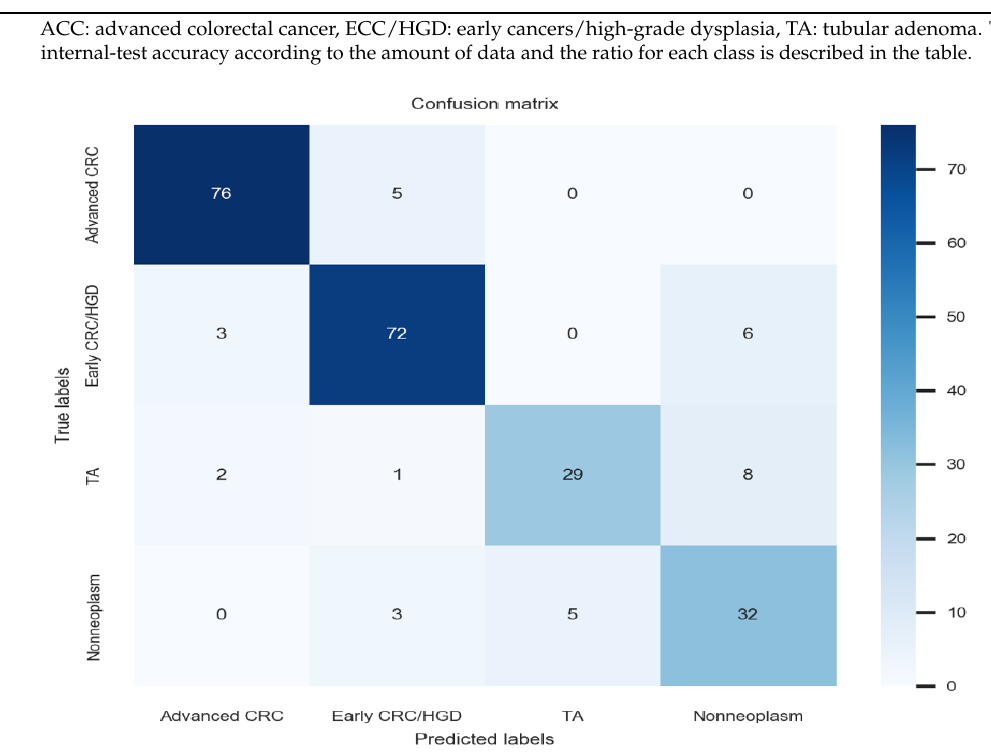
Figure 2. Best-performing artificial intelligence model confusion matrix (internal-test). ACC: ad- vanced colorectal cancer, ECC/HGD: early cancers/high-grade dysplasia, TA: tubular adenoma.